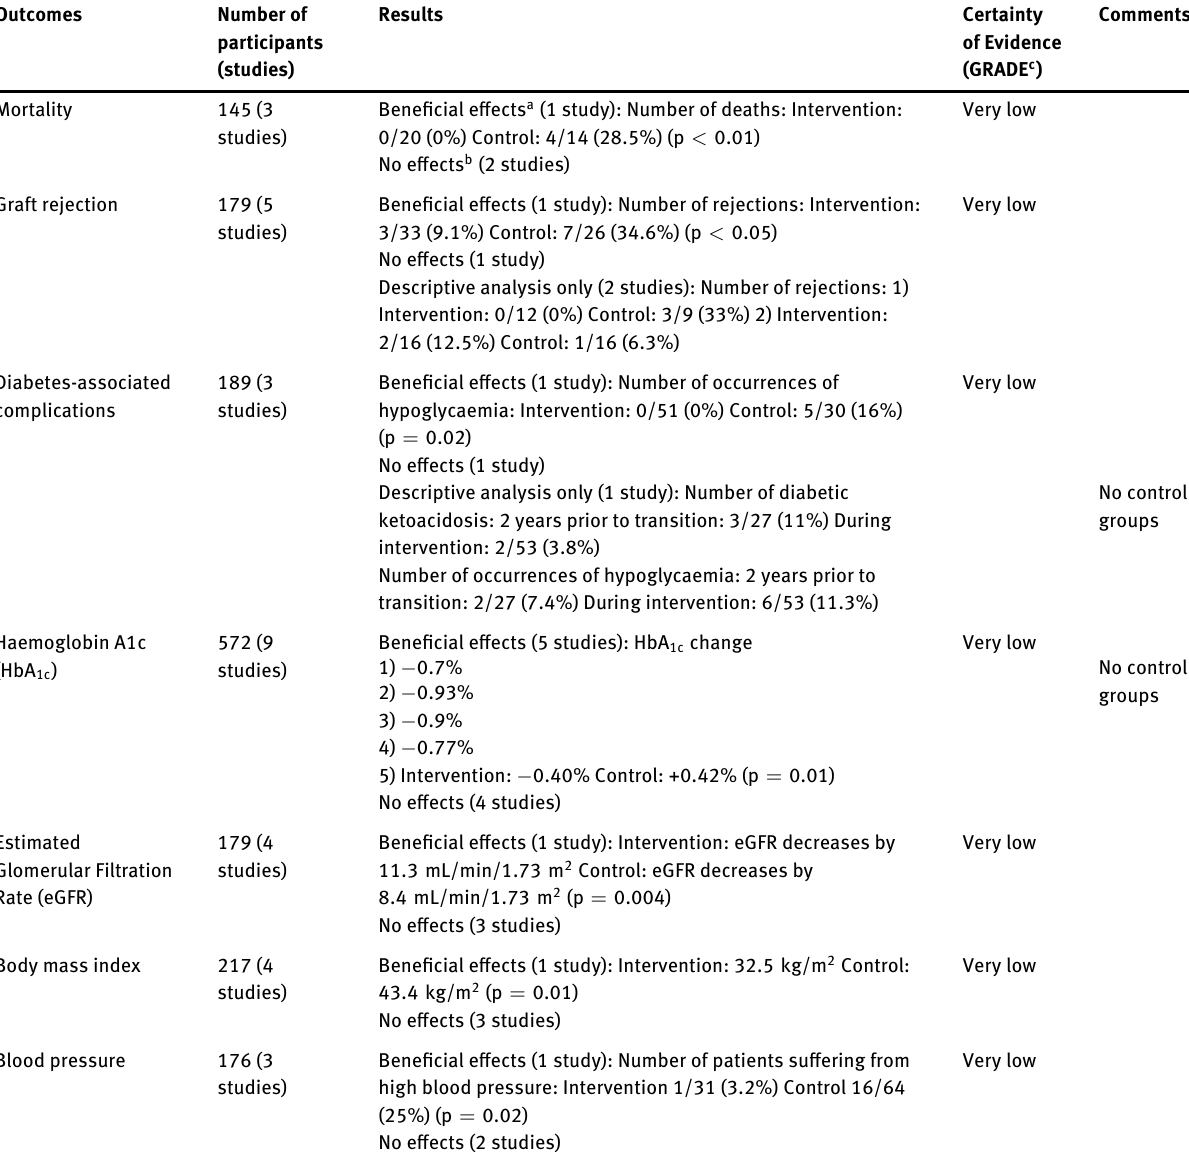
Table 3: Summary of findings of most frequently assessed outcomes. Outcomes Number of